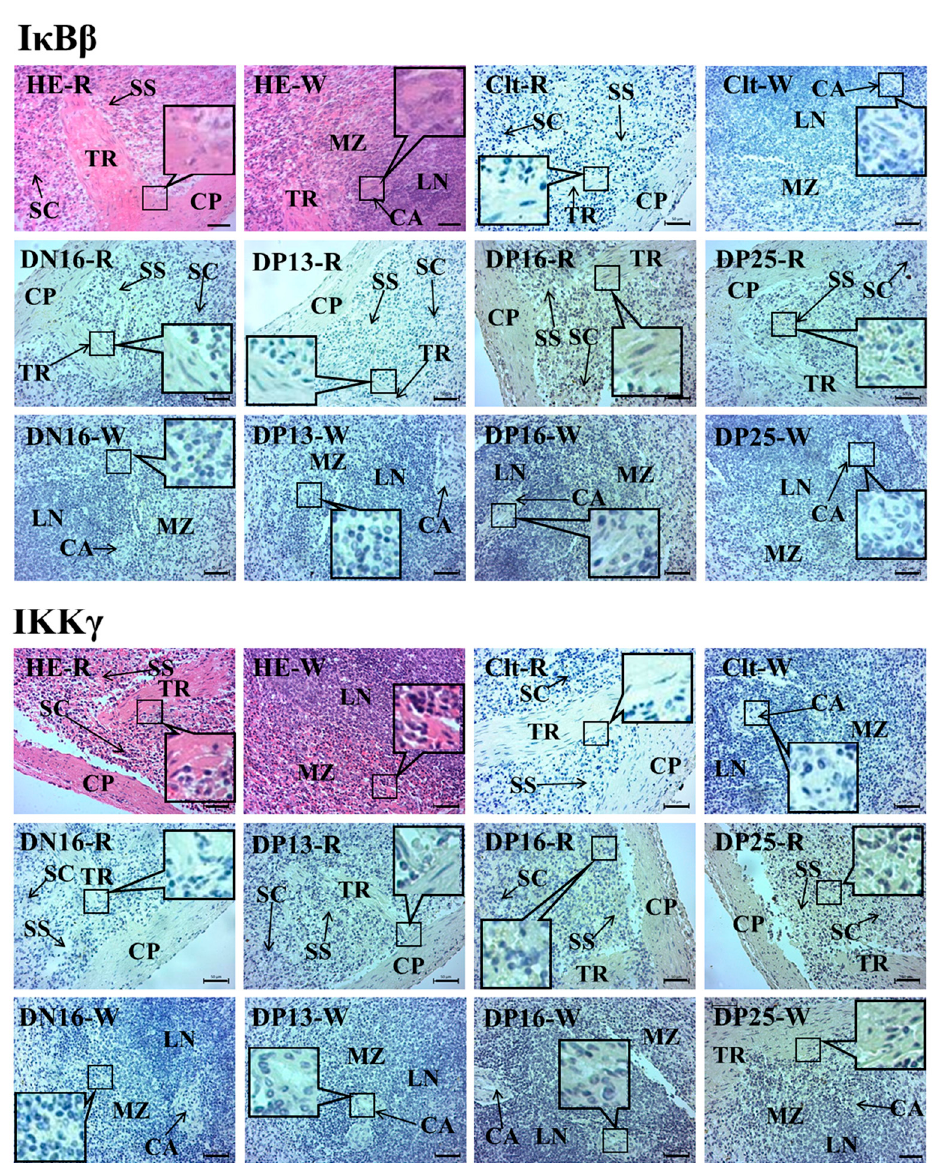
Figure 5. Representative immunohistochemical localization of I κ B β and IKK γ proteins in ovine spleen. The spleen is divided into red pulp (R) and white pulp (W), and surrounded by a thickened capsule. Capsule (CP) with several trabeculae (TR) projects into the substance of the spleen. Note: HE = stained by hematoxylin and eosin; Clt = negative control; SS = splenic sinuses; SC = splenic cords; MZ = marginal zone; LN = lymphoid nodule; CA = central arteriole; DN16 = day 16 of the estrous cycle; DP13 = day 13 of pregnancy; DP16 = day 16 of pregnancy; DP25 = day 25 of pregnancy. Bar = 50 µm.